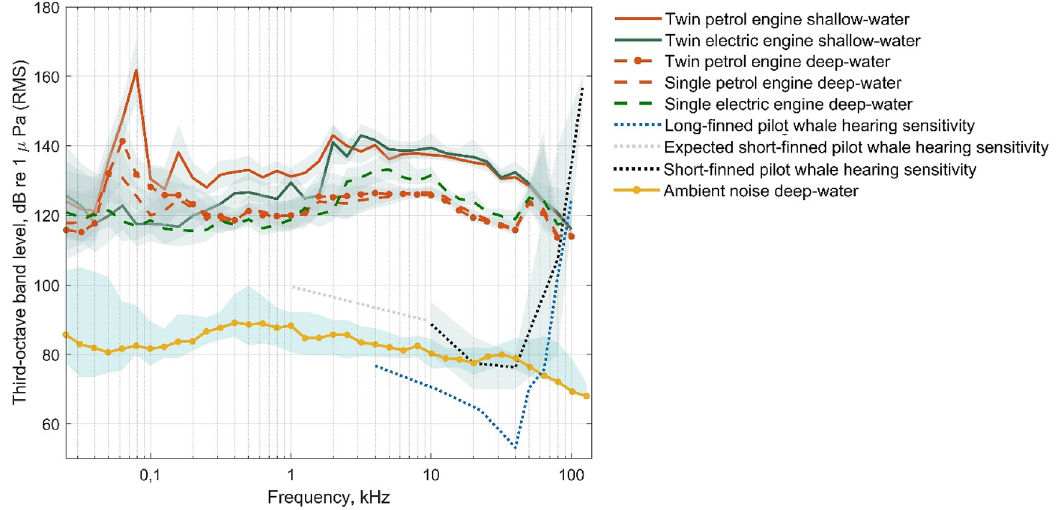
Figure 3. Whale-watch vessel third-octave band levels (TOLs) in dB re 1 µPa (RMS) for single and twin petrol and electric engines in shallow and deep-water habitats off Tenerife. Underwater ambient noise TOLs in a deep-water habitat off Tenerife (~ 1000 m water depth) were measured from SoundTraps at 4 and 400 m depth. The shaded regions represent the 95% confidence intervals. The audiogram of the short-finned pilot whale